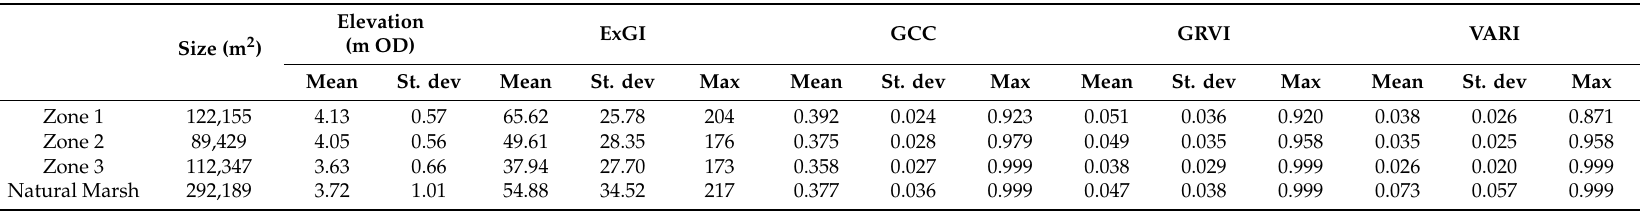
Table 3. Summary statistics of the size, elevation, and the Excess Greenness Index (ExGI), Green Chromaticity Coordinates (GCC), Green Red Vegetation Index (GRVI), and Visible Atmospherically Resistant Index (VARI) vegetation indices for the three zones identified within Cwm Ivy Marsh Managed Realignment Site (see Figure 1 for locations) and the surrounding natural